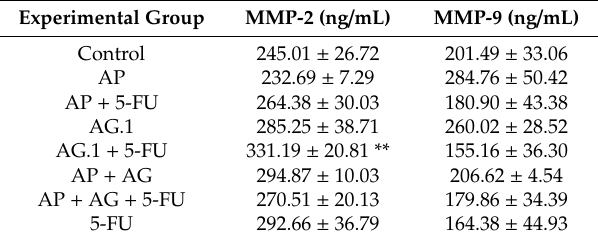
Table 6. E ff ect of treatment with Agarikon Plus, Agarikon.1 and 5-fluorouracil in various combinations on MMP-2 and MMP-9 levels in serum supernatant of mice bearing CT26.WT tumors.